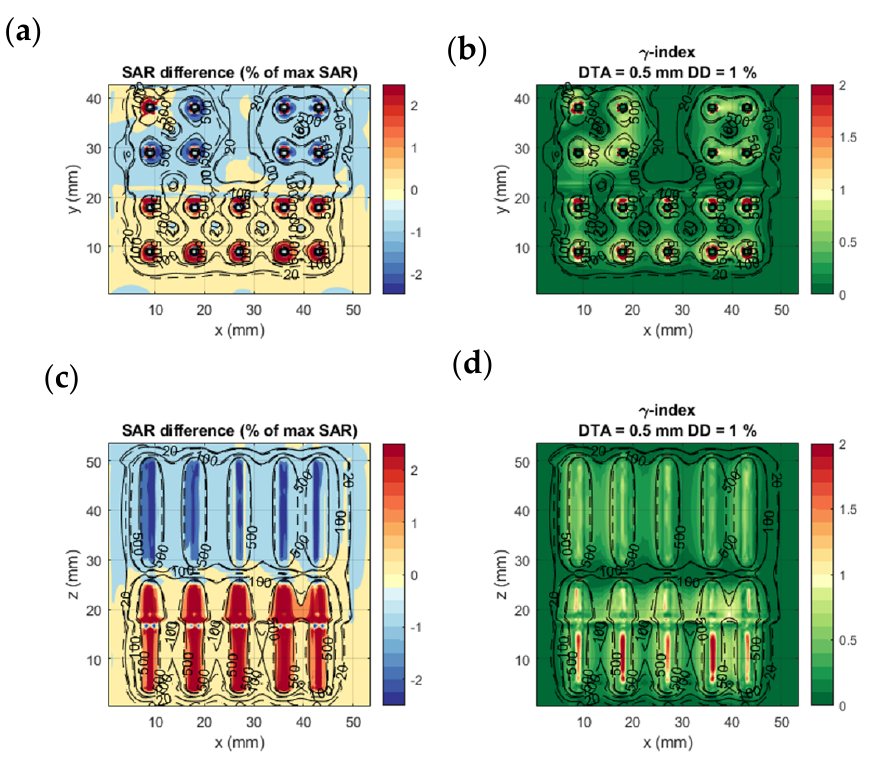
Figure 6. Complex benchmarking model: SAR difference between calculation method 1 and 4 ( a , c )